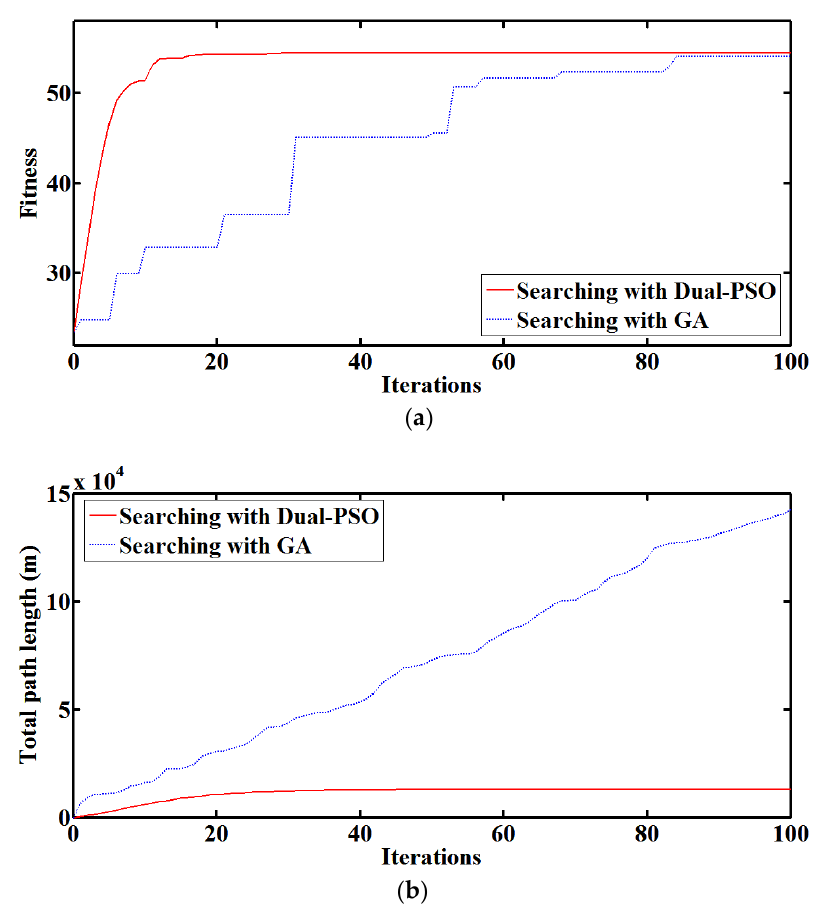
Figure 11. Comparison of water pollution source searching with Dual-PSO and GA: ( a ) The convergence curves; ( b ) The total path length of mobile nodes during searching.